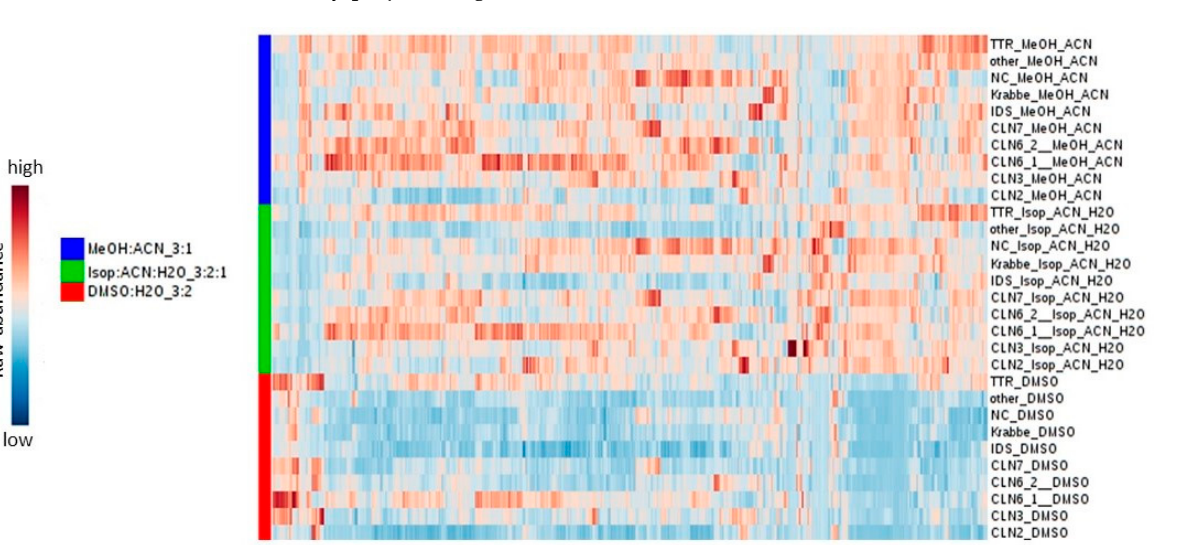
Figure 8. Boxplots showing the distribution of a random metabolite (4.40_421.2811 m/z ) across different extraction solvents. Control–asymptomatic LSD subjects ( n = 12); affected–LSD symptomatic patients ( n = 8). Box = 25th and 75th percentiles; bars = min and max values. 2.2.2. Methanol–Acetonitrile (3:1) Ranks Well in Terms of Metabolome Coverage and Metabolite Intensity The next step was a comparative study of methanol–acetonitrile (3:1, v/v ) with other methanol mixtures at various ratios, such as methanol 100%, methanol–water (1:1, v/v ), and methanol–acetonitrile (1:1, v/v ). The results were evaluated based on the total number of features and their abundances. Methanol–acetonitrile (3:1, v/v ) proved to be the most effective mixture for extracting metabolites with high intensity. Table 1a shows the subtle but significant differences among the four different extraction solvents and the compari- son of the various methanol mixtures. The considerable overlap between methanol 100% and methanol: acetonitrile (1:1, v/v ), Table 1b, is noteworthy in terms of metabolome cov- erage and the number of features with high intensity.